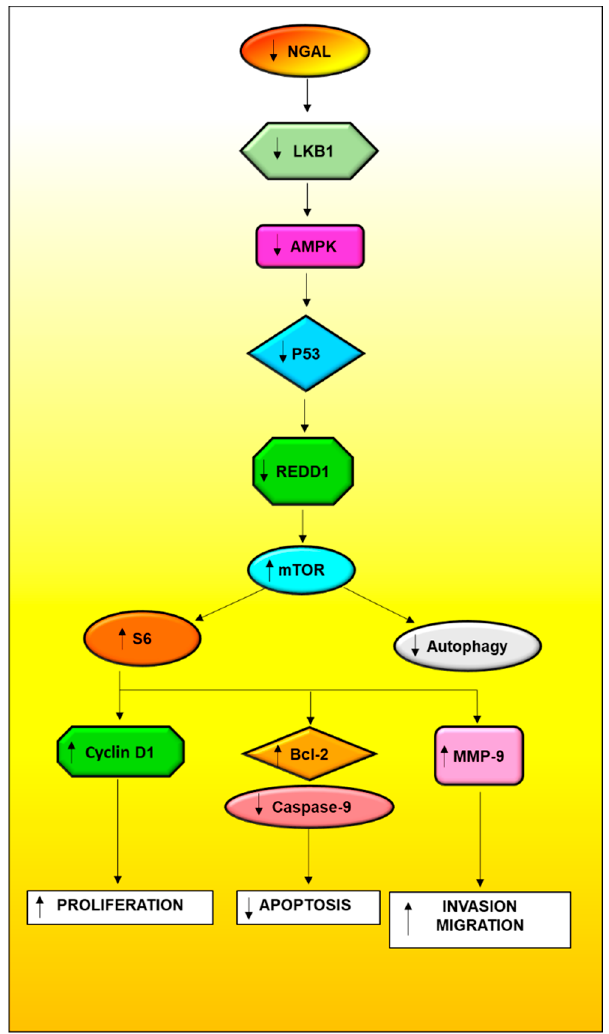
Figure 7. Downregulation of NGAL activates mTOR signaling via LKB1-AMPK-p53-Redd1 and decreases